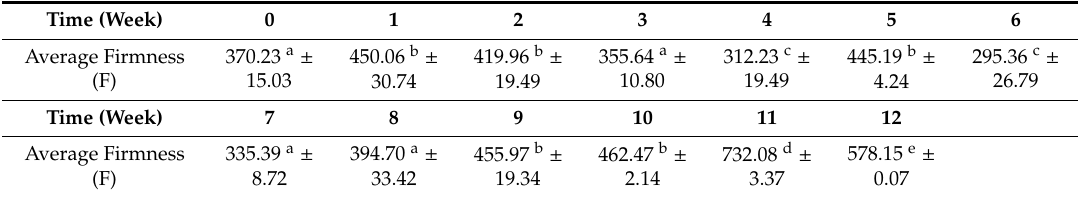
Table 4. Firmness of sponge cakes in air-cooled condition.